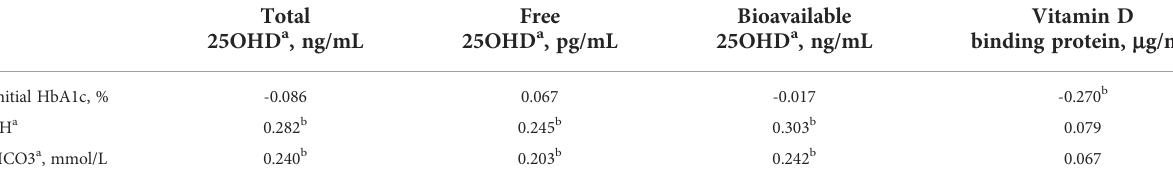
TABLE 2 Association of vitamin D metabolites with biochemical parameters at the time of T1DM diagnosis. Free Bioavailable Total 25OHD a , pg/mL 25OHD a , 25OHD a , ng/mL